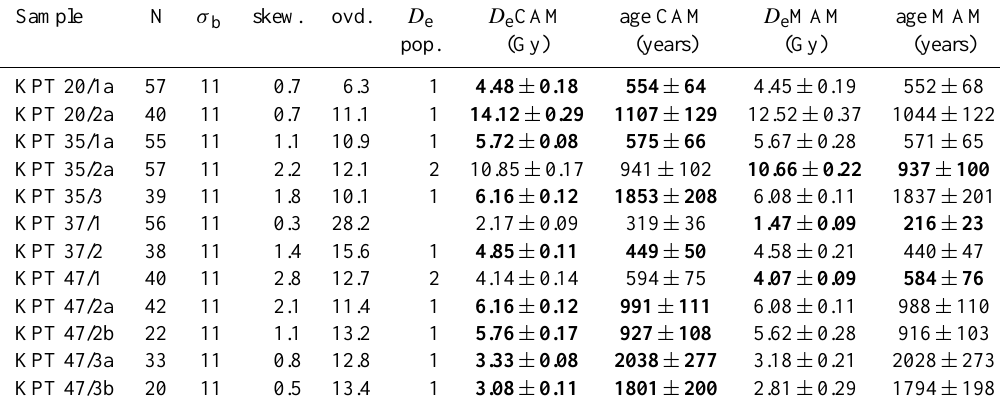
Fig. 8. The different types of D e distribution. Grey shaded areas mark mean D e values calculated with CAM. Encircled numbers indicate D e populations. Table 3. Summarised characteristics of the D e distributions, mean equivalent doses, age models and ages for all samples (results of selected model in bold type). σ b = expected scatter, skew. = skewness, ovd. = over-dispersion, D e pop. = number of signal populations, CAM = central age model, MAM = minimum age